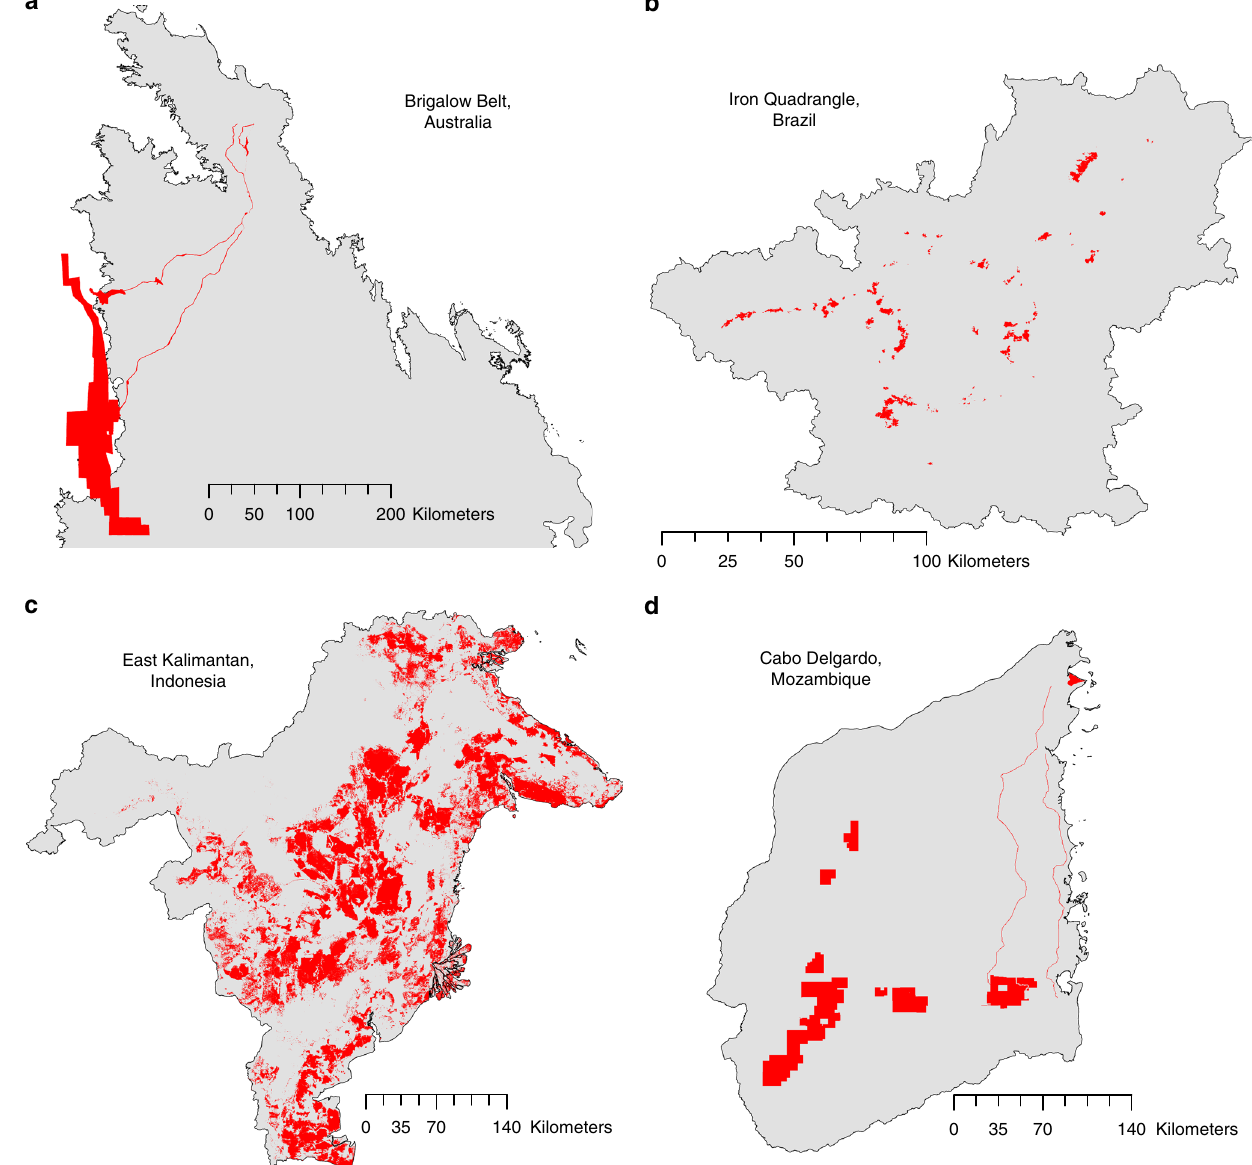
Fig. 1 Four case studies, which differ markedly in regulated development (shown in red) and local conditions. a Brigalow Belt, Australia; b Iron Quadrangle, Brazil; c East Kalimantan, Indonesia; d Cabo Delgado, Mozambique. Regulated development represents new mining areas and related infrastructure in the Brigalow Belt and Cabo Delgado; new mining areas in the Iron Quadrangle; and new mining areas and oil palm plantations in East Kalimantan. See Table 1 for summaries of how local conditions differ among